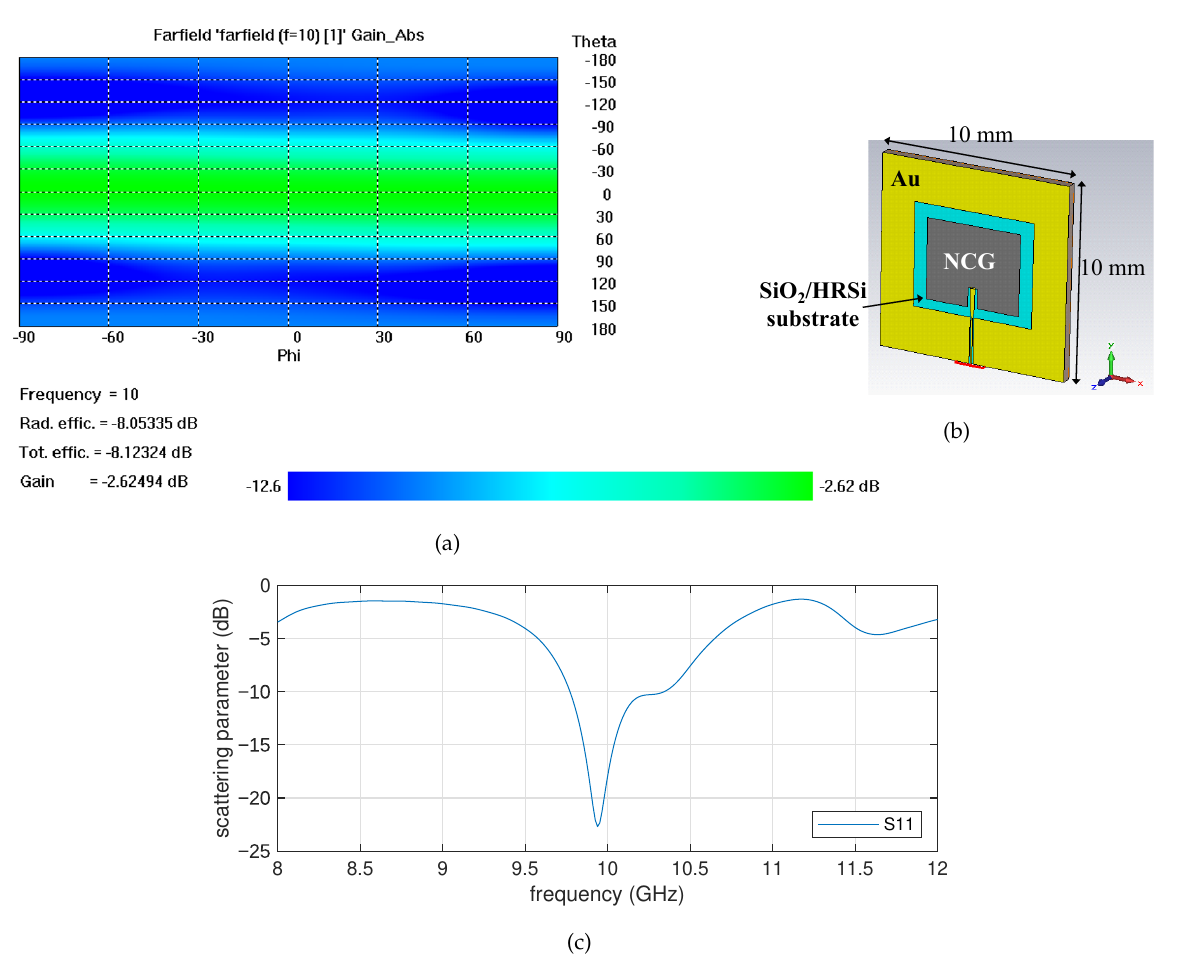
Figure 8. ( a ) CST Microwave Studio simulated 2D gain of the 10 GHz NCG-based patch antenna whose 3D layout is shown in ( b ); the angle θ is upon the ( x , z ) plane, whereas the angle φ lies on the antenna plane ( x , y ) ; ( c ) simulated reflection coefficient S 11 of the antenna in the X